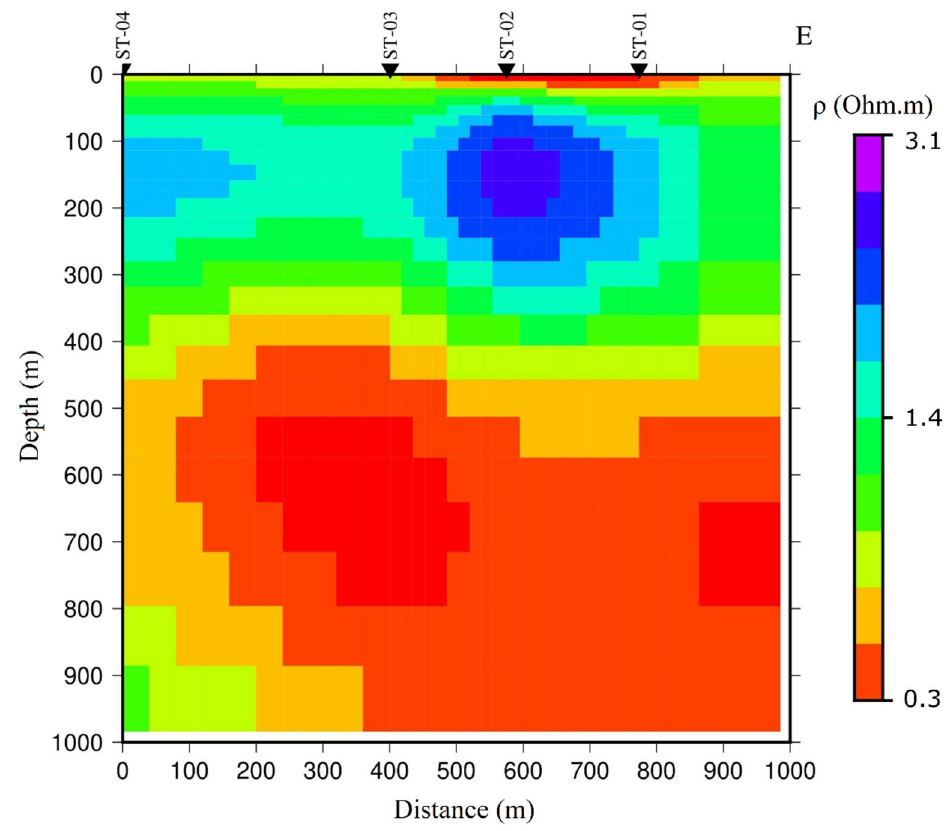
Figure 15. 2D inverted resistivity